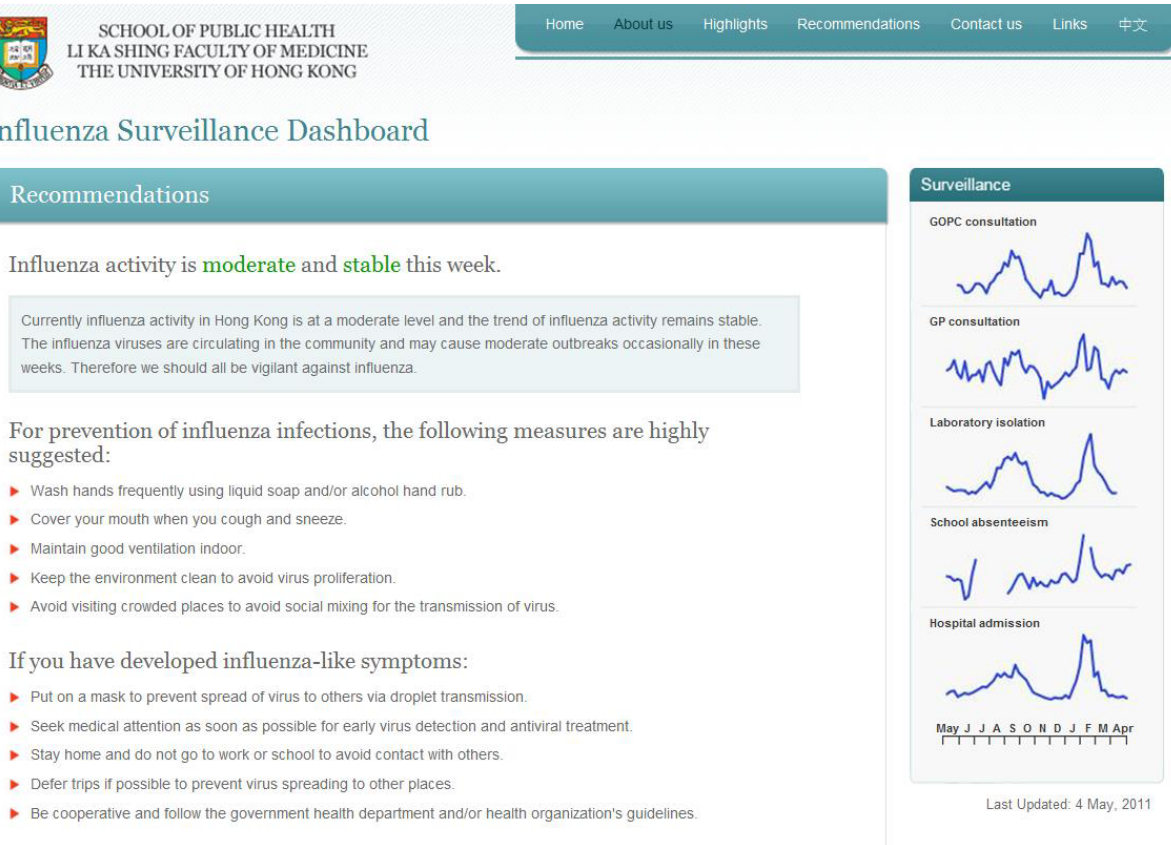
Figure 4. Screenshot of the Recommendations drill-down page in the influenza surveillance